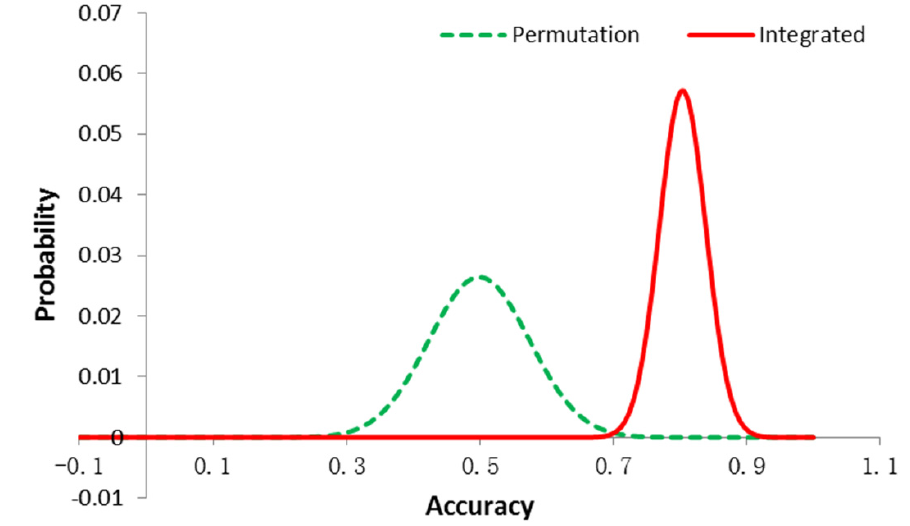
Figure 4. Prediction accuracy of integrated model and permutated